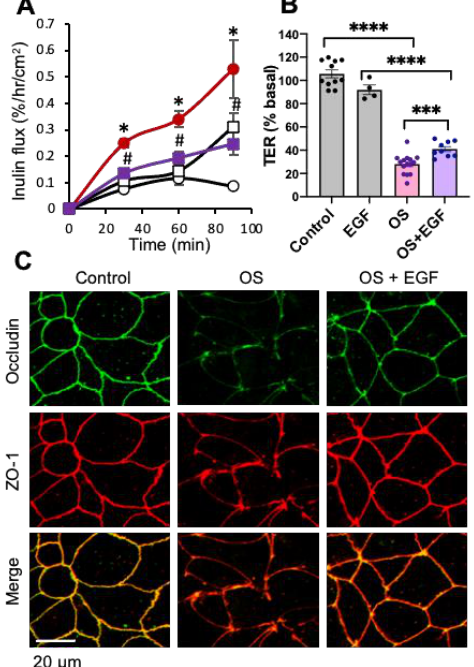
Figure 3. EGF prevents osmotic stress-induced tight junction disruption and barrier dysfunction in Caco-2 cell monolayers. ( A , B ) Caco-2 cell monolayers (13–15 days post-seeding) were pretreated with (□, ■ ) or without ( ○ , ●) EGF (30 nM) for 30 min followed by osmotic stress (OS) by incubation in hyperosmotic medium (●, ■ ). Inulin flux ( A ) and TER ( B ) were measured at varying times. The control group received similar treatments in the iso-osmotic medium. Values are mean ± SEM (n = 3–17 from six experiments for the time course of inulin flux; n = 3–15 from five experiments for TER measured after 90 min OS). In panel A, * indicates the OS values (●) that are significantly ( p < 0.05) different from the corresponding CTL values ( ○ ); # indicates that OS + LC values ( ■ ) are significantly ( p < 0.05) different from corresponding OS values (●). In panel B, asterisks represent significant difference between indicated groups; *** = p < 0.005; **** = p < 0.001. ( C ) After 90 min OS treatment, cell monolayers were fixed and co-stained for occludin (green) and ZO-1 (red). Fluorescence images were captured by confocal microscopy. The orange color in merged images indicate co-localization of occludin and ZO-1.